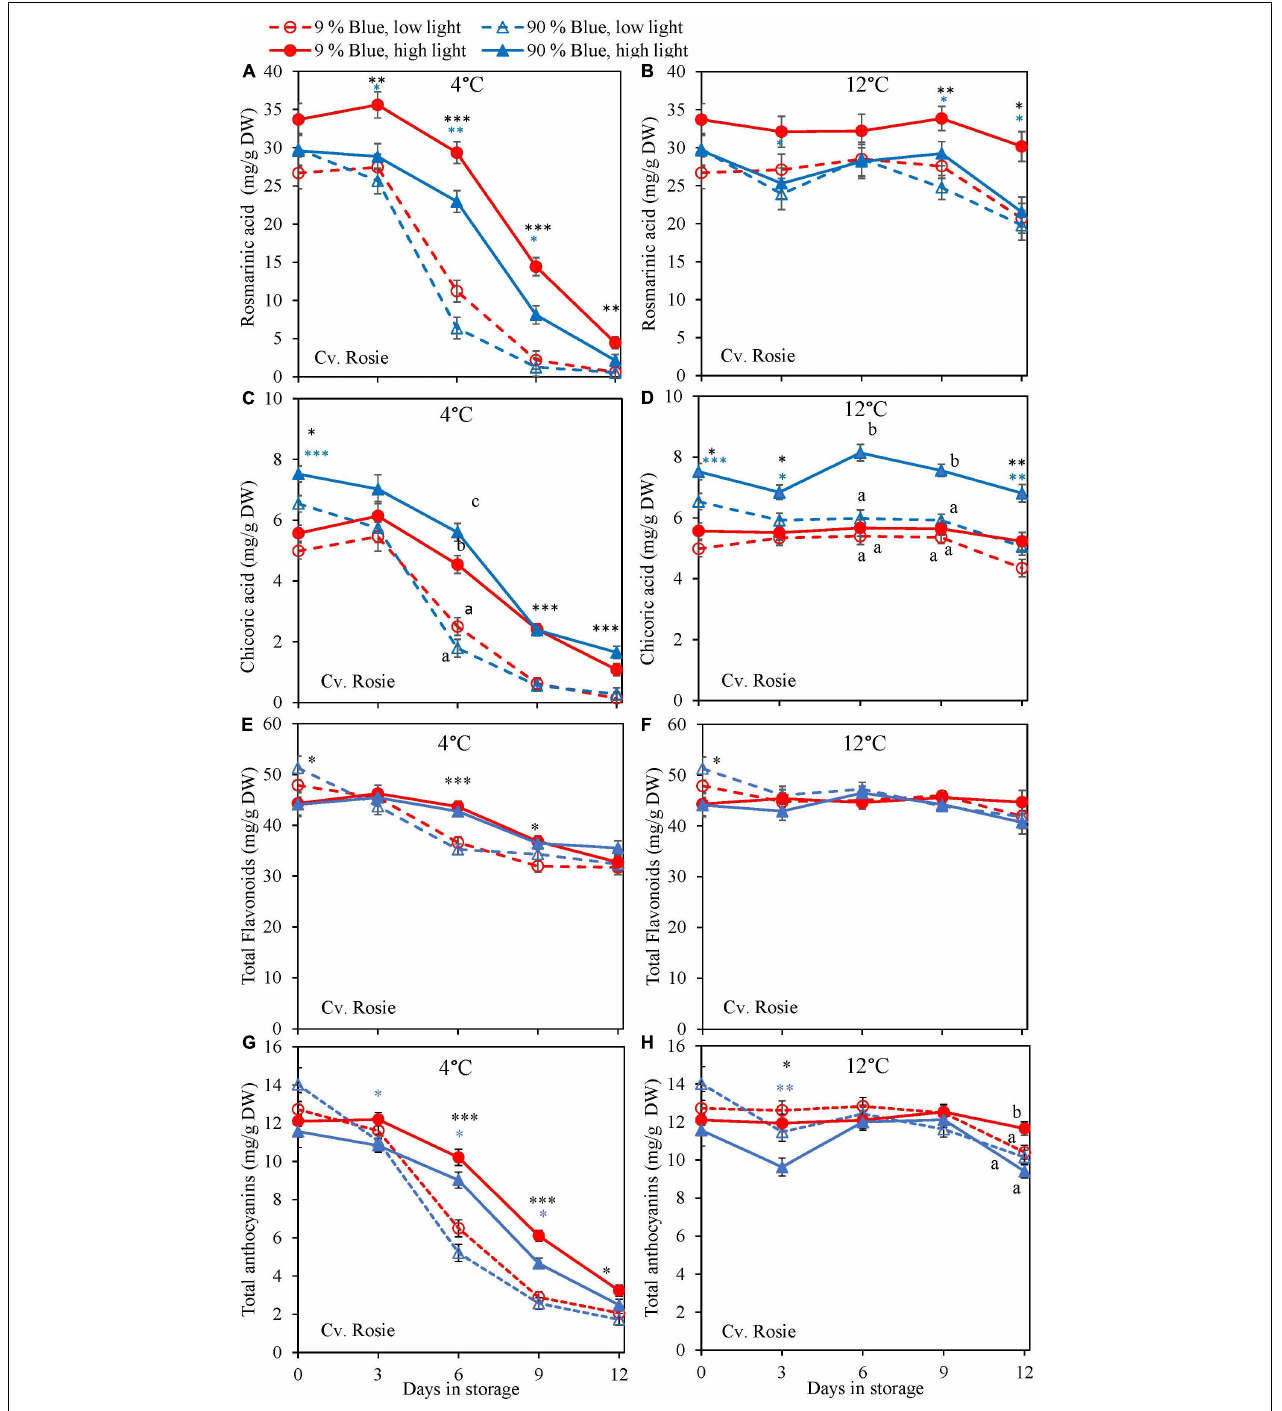
FIGURE 5 | Changes in metabolite levels during postharvest storage at 4 (A,C,E,G) and 12 ◦ C (B,D,F,H) in basil in the purple cv. Rosie were exposed to EOP treatments. Plants were grown under red-white light (PPFD of 200 µ mol m − 2 s − 1 , 9% blue) for 30 days. The last 5 days before harvest plants were exposed to different EOP blue light ratios 9 or 90% at low PPFD (100 µ mol m − 2 s − 1 ) (open symbols) or high PPFD (300 µ mol m − 2 s − 1 ) (closed symbols). (A,B) Change in rosmarinic acid, (C,D) change in chicoric acid, (E,F) change in total flavonoid content, (G,H) change in total anthocyanin content. All values are expressed per gram dry weight in the leaves. The data are means of four blocks ( n = 4) (i.e., per block four replicate plants). Standard errors of means are shown as error bars. If no interaction was found but only the main effects were significant the indicated with p -values; ∗ p < 0.05, ∗∗ p < 0.01, ∗∗∗ p < 0.001 are depicted with either a blue (percentage of blue light) or black asterisk (PPFD). Letters indicate and interactive effect between the two main effects (percentage of blue light and PPFD), (Experiment 2).